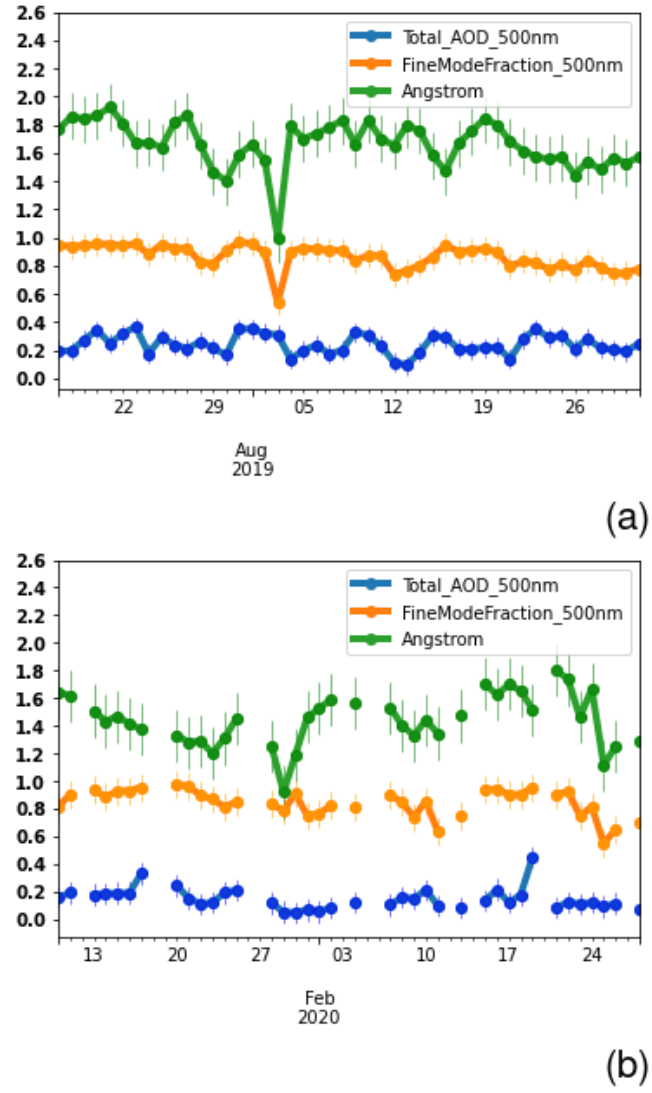
Figure 6. Temporal evolution of aerosol optical depth (AOD) at 500 nm, Fine mode fraction at 500 nm and Ångström exponent, along with their standard deviation retrieved by the sunphotometer measurements during ( a ) the summer and ( b ) winter PANACEA campaigns in Thessaloniki station. Concerning the columnar Lidar Ratio (LR) values, high values are observed during both the summer and winter campaigns (up to 90 sr at 440 nm). During the summer period, the LR at 440 nm had a mean value of 70 ± 9 sr, while the winter period the mean LR at 440 nm was found equal to 73 ± 14 sr. Generally, the LR values at a given wavelength depend on both the chemical composition and the particle shapes, with higher values representative for the existence of more absorbing